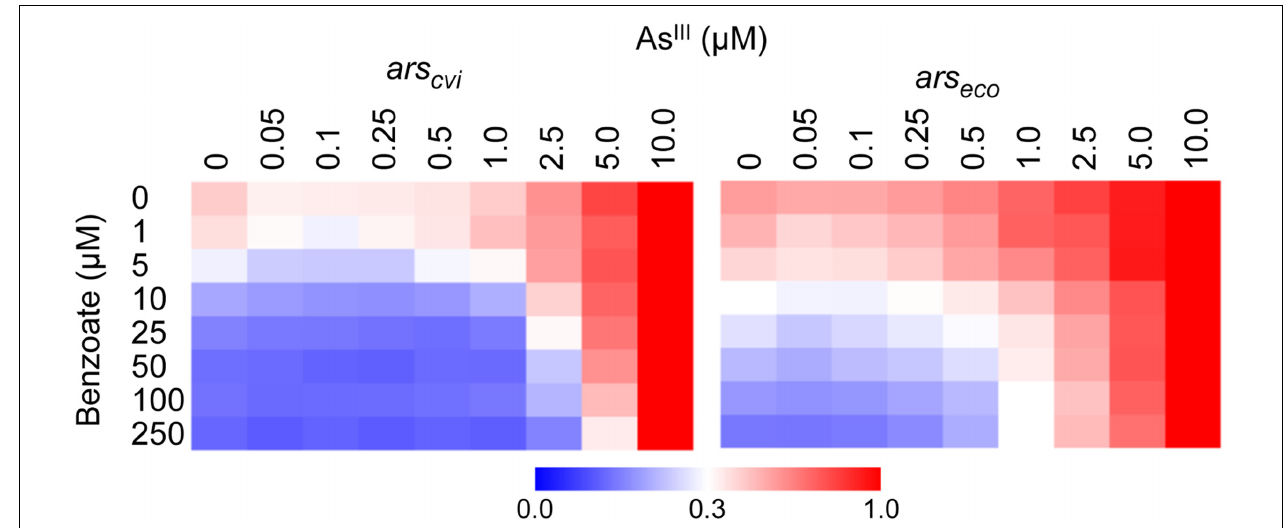
FIGURE 5 | Expression dynamics of ars systems from E. coli and C. violaceum under varying concentrations of benzoate and As III . E. coli AW3110 ( (cid:49) ars ) harboring the circuits represented in Figure 3A were exposed to varying concentrations of benzoate and As III and incubated for 6 h to allow induction. Promoter activities (calculated as GFP/OD 600 ) were normalized to the maximal level obtained with 10 µ M of As III . Data are representative of three independent